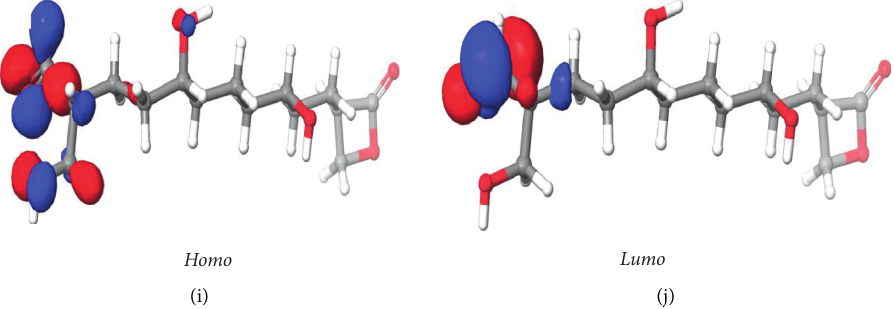
Figure 4: HOMO and LUMO mapping of 250395 (a, b), 129677029 (c, d), 44259583 (e, f), 4425984 (g, h), and 88583189 (i, j) Kabasura Kudineer compounds. Blue and red color regions represent positive and negative potential, respectively.